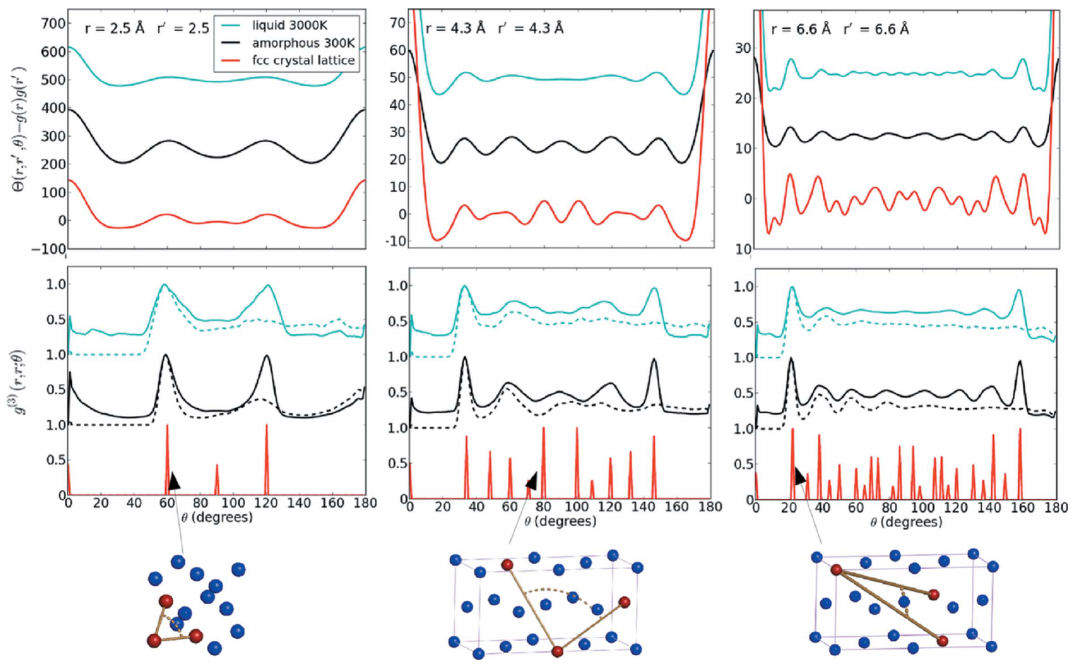
Figure 3 The angular dependence of (cid:2) ð r ; r 0 ;(cid:2) Þ for three different radial shells: r ¼ r 0 ¼ 2 : 5 A˚ (top left), r ¼ r 0 ¼ 4 : 3 A˚ (top middle) and r ¼ r 0 ¼ 6 : 6 A˚ (top right). The peak positions show good agreement with the sum ~ gg ð 3 Þ ð r ; r 0 ;(cid:2) Þ þ ~ gg ð 3 Þ ð r ; r 0 ;(cid:5) (cid:3) (cid:2) Þ shown by the solid lines in the second row that are calculated directly from the simulated atomic structures. The dashed lines in the second row show the asymmetric correlation ~ gg ð 3 Þ ð r ; r 0 ;(cid:2) Þ for reference. All ~ gg ð 3 Þ ð r ; r 0 ;(cid:2) Þ plots have been normalized to a maximum value of unity. The lattice diagrams are examples of the atoms from the f.c.c. lattice (in red) that contribute to peaks in ~ gg ð 3 Þ ð r ; r 0 ;(cid:2) Þ . To aid comparison, the plots have been offset and (cid:2) ð r ; r 0 ;(cid:2) Þ has been scaled by a factor of 7 (cid:9) 10 (cid:3) 5 for the crystalline case and by factor of 5 for the liquid